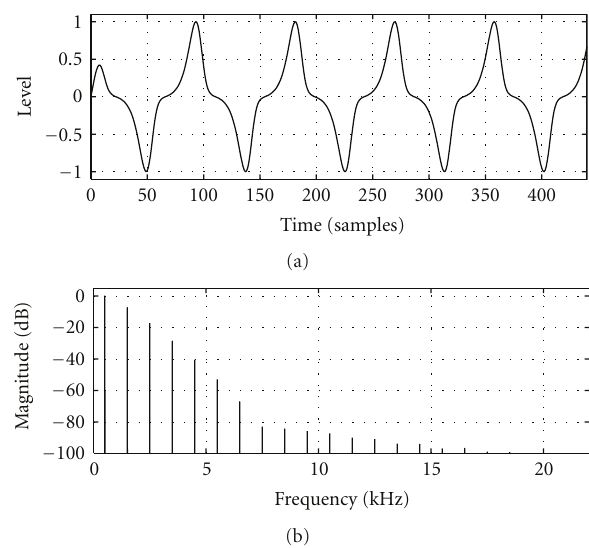
Figure 15: FBAM variation 4 with cosine waveshaping ( β = 1, f 0 = 500Hz), see Figure 10(e). The transient appears because the initial state of the filter was not set up appropriately.